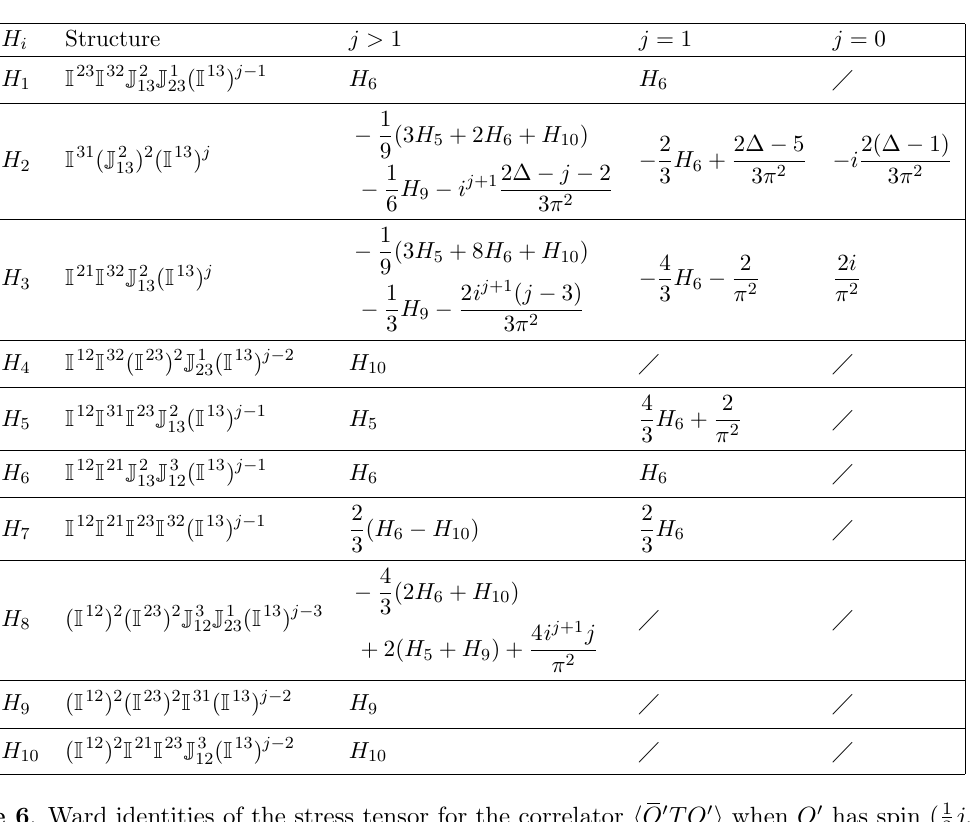
and is assumed to be unit normalized. If O 0 = QO the terms not proportional to 2 . ( QO )